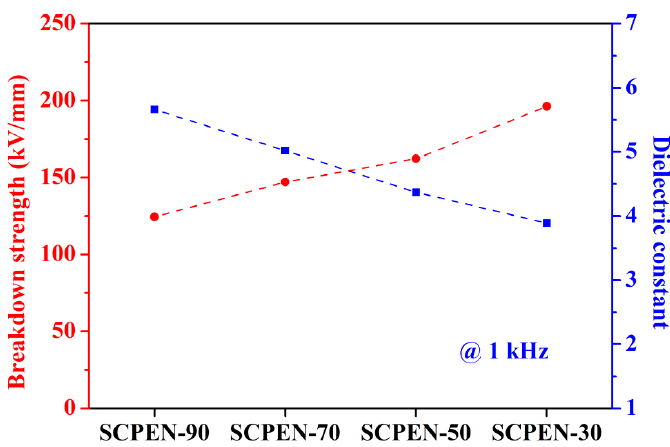
Figure 9. The breakdown strength and dielectric constant of SCPEN films at 1 kHz.